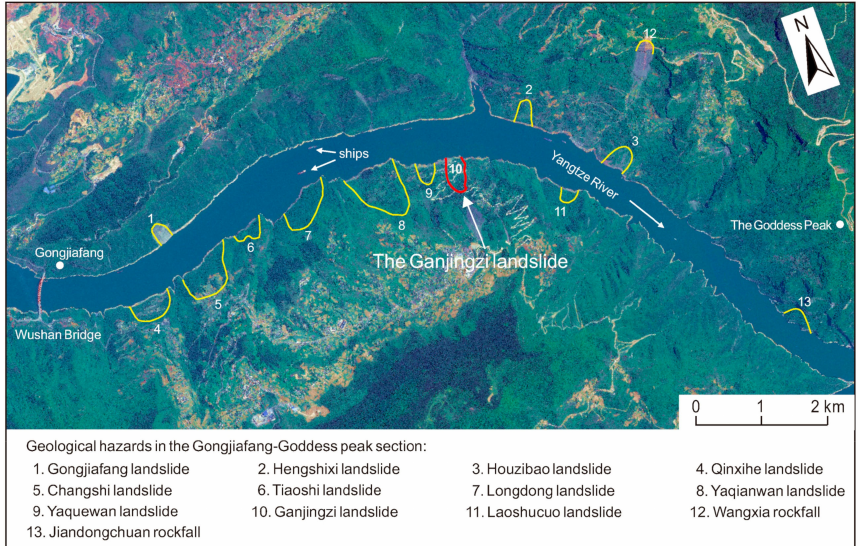
Figure 3. Geological hazards in the Gongjiafang-Goddess peak section of the Wu